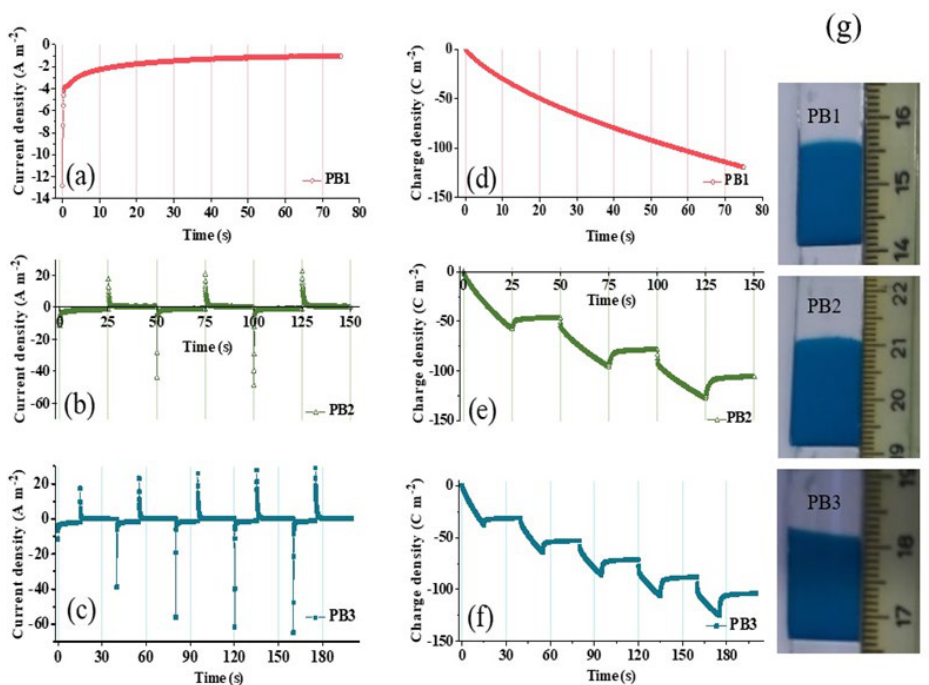
Figure 1. In ( a – c ) are the current densities vs. time, measured during the electrodeposition process, in the samples prepared with DC chronoamperometry (PB1), symmetric pulse (PB2), and non-symmetric pulse (PB3) electrodeposition techniques. In ( d – f ) are the corresponding charge densities vs. time. In ( g ) is the physical view of the PB samples.